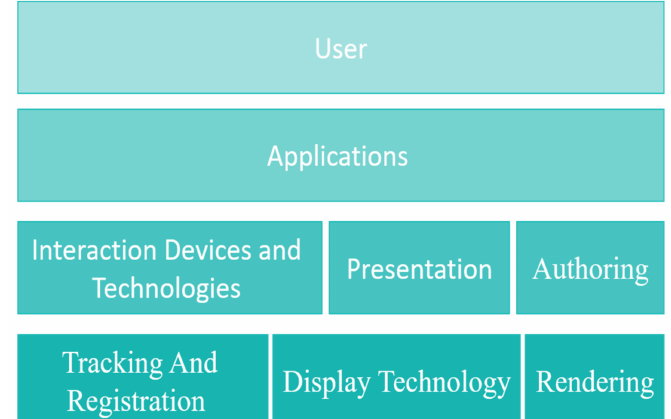
Figure 6. The component of